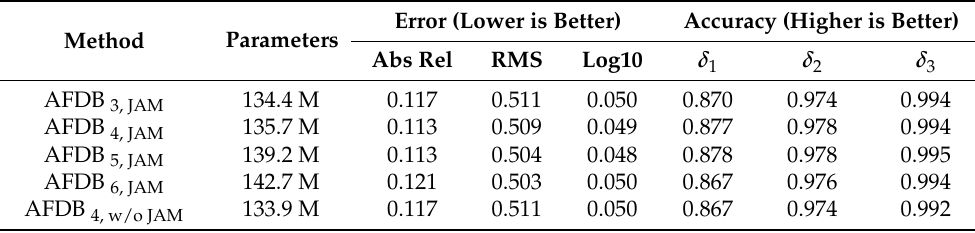
Table 4. The AFDB performance under different settings. Method subscripts show the distillation steps (w/o means without). JAM: joint attention